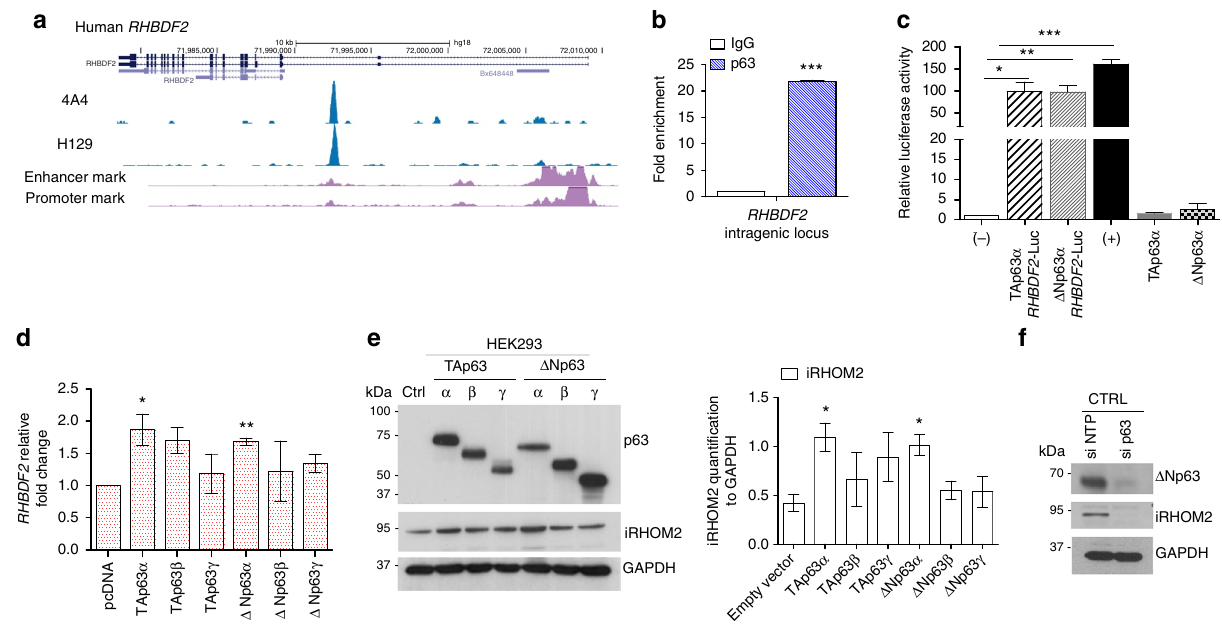
Fig. 1 Identi fi cation of iRHOM2 as a p63 target gene in keratinocytes. a Screenshot of the UCSC genome browser from ChIP-seq analysis of normal human primary keratinocytes with two different antibodies (4A4, pan-p63 and H129, α -speci fi c). The ChIP-seq study was previously reported. b Chromatin immunoprecipitation in control keratinocytes (CTRL) with anti-pan p63 (H137) and anti-IgG antibodies followed by quantitative PCR (ChIP-qPCR) analysis showed that p63 binds to RHBDF2 intragenic region. Error bars represent SEM of three independent experiments and Student ’ s two-tailed t -test value is shown; *** p < 0.001. c Luciferase assay for RHBDF2 gene locus. The construct was transiently transfected into HEK293 cells in the absence ( − ) or in the presence of Δ Np63 α or TAp63 α . The ( + ) control corresponds to IRF6p229-Luc plasmid. The activity of the intragenic region was measured by luciferase assay and values are expressed relative to ( − ) set to 1. Data were analysed using two-tailed Student ’ s t -test (* p < 0.05, ** p < 0.01 and *** p < 0.001). d qRT- PCR for RHBDF2 in HEK293 cells transfected with TA and Δ Np63 isoforms. The graph represents means and SEM of three biological replicates after 9 h of transfection. Statistical analysis was performed by Student ’ s two-tailed t -test comparing pcDNA transfected cells to other samples. e Immunoblotting of HEK293 cells over-expressing p63 isoforms, showed TA and Δ Np63 isoforms ( α -pan p63) and iRHOM2 expression after 9 h of transfection. GAPDH was used as loading control. The graph represents the means of the quanti fi cation, using ImageJ software, from three independent experiments relative to GAPDH. Error bars represent SEM and Student ’ s two-tailed t -test values are given * p < 0.05. f Representative western blotting (WB) shows expression of Δ Np63 and iRHOM2 in normal keratinocytes (CTRL) treated with non-targeted protein (NTP) or p63 siRNAs. GAPDH was used as a loading